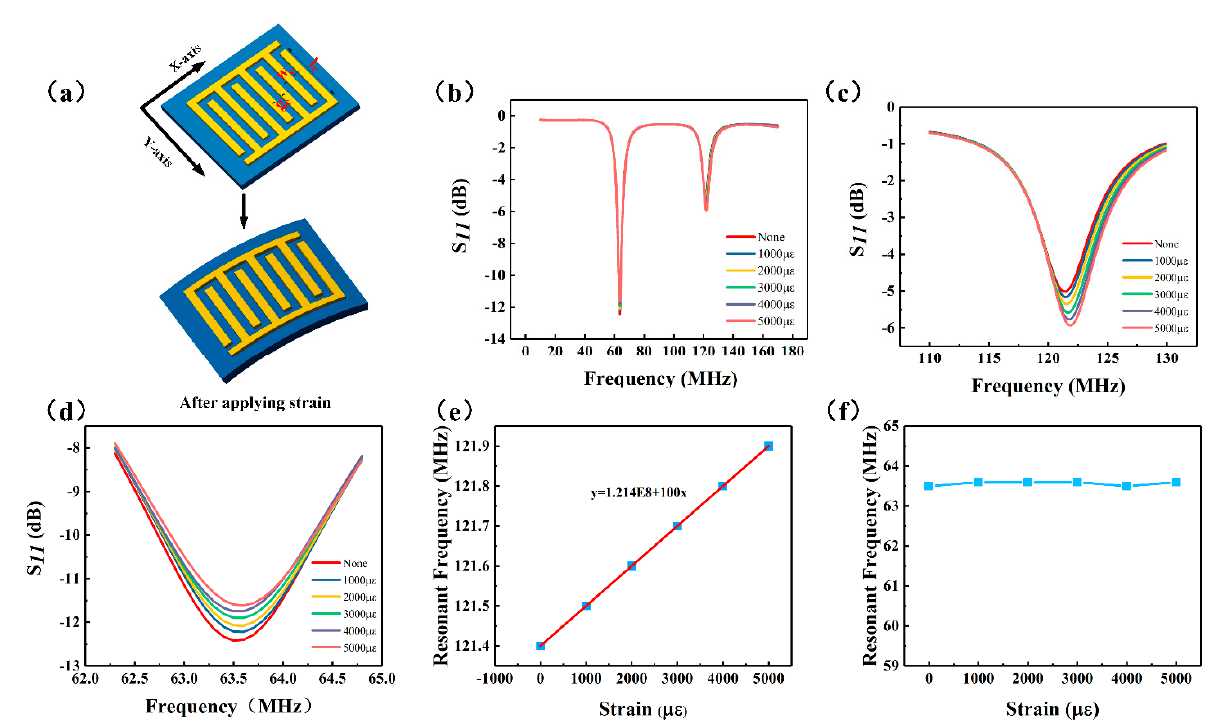
Figure 4. Strain results of the dual-parameter wireless sensor: ( a ) Diagram used to explain the strain mechanism; ( b ) 0– 5000 με strain response curve of the dual-parameter sensor; ( c ) Enlarged view of the strain response curve of the strain- sensitive unit; ( d ) Enlarged view of the strain response curve of the temperature-sensitive unit; ( e ) Fitted curve of the strain response of the strain-sensitive unit, and ( f ) Fitted curve of the strain response of the temperature-sensitive unit.